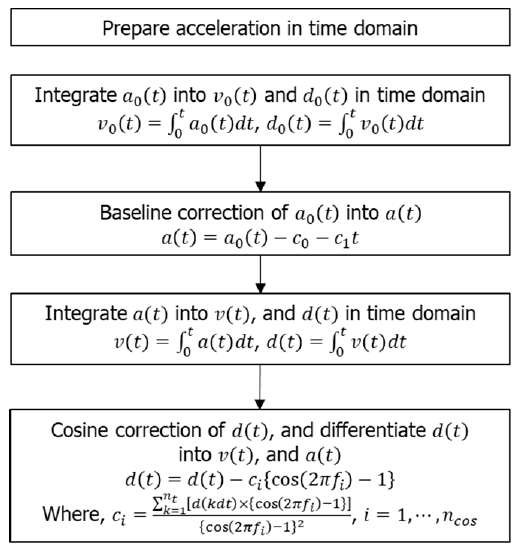
Figure 6. Flowchart for the conversion of acceleration data using Method 2.